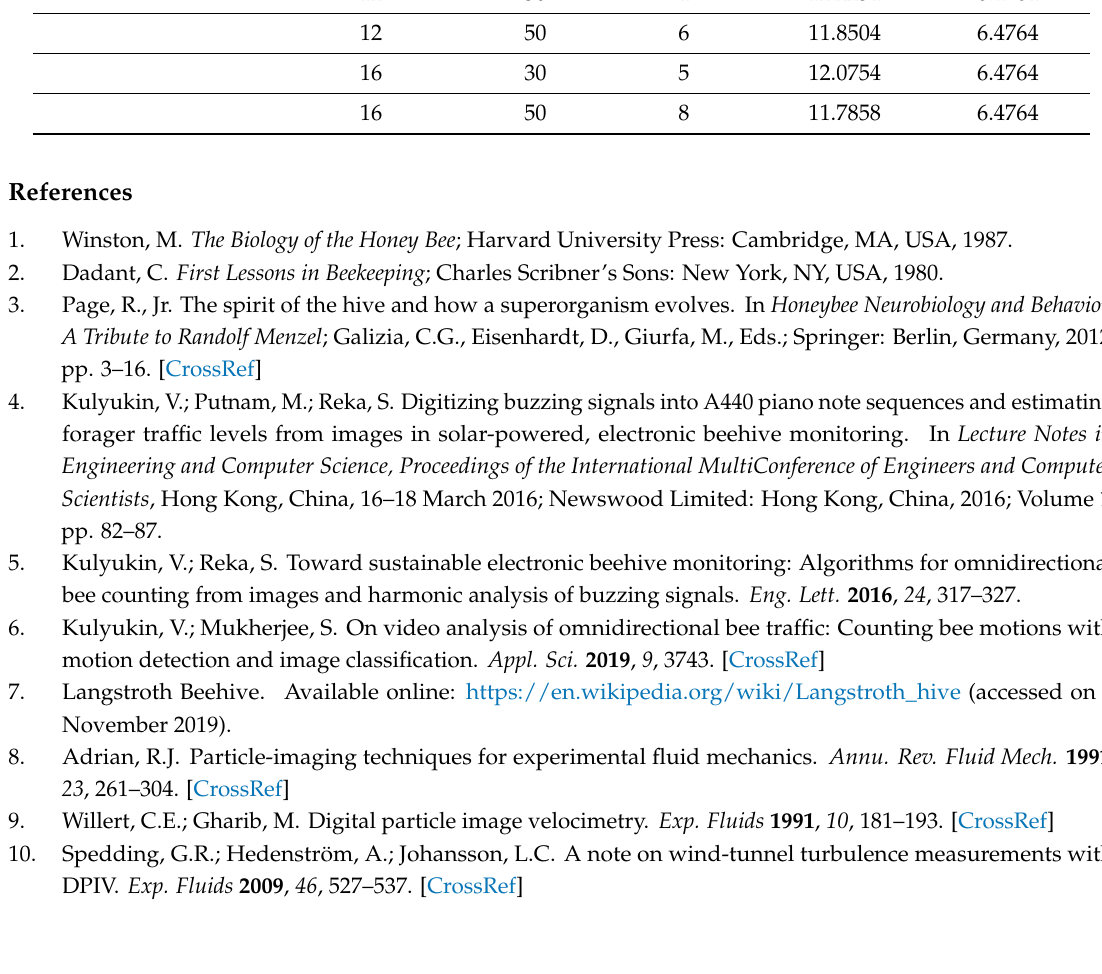
is DPIV; C ∗ is MOG2/VGG16; 2 1